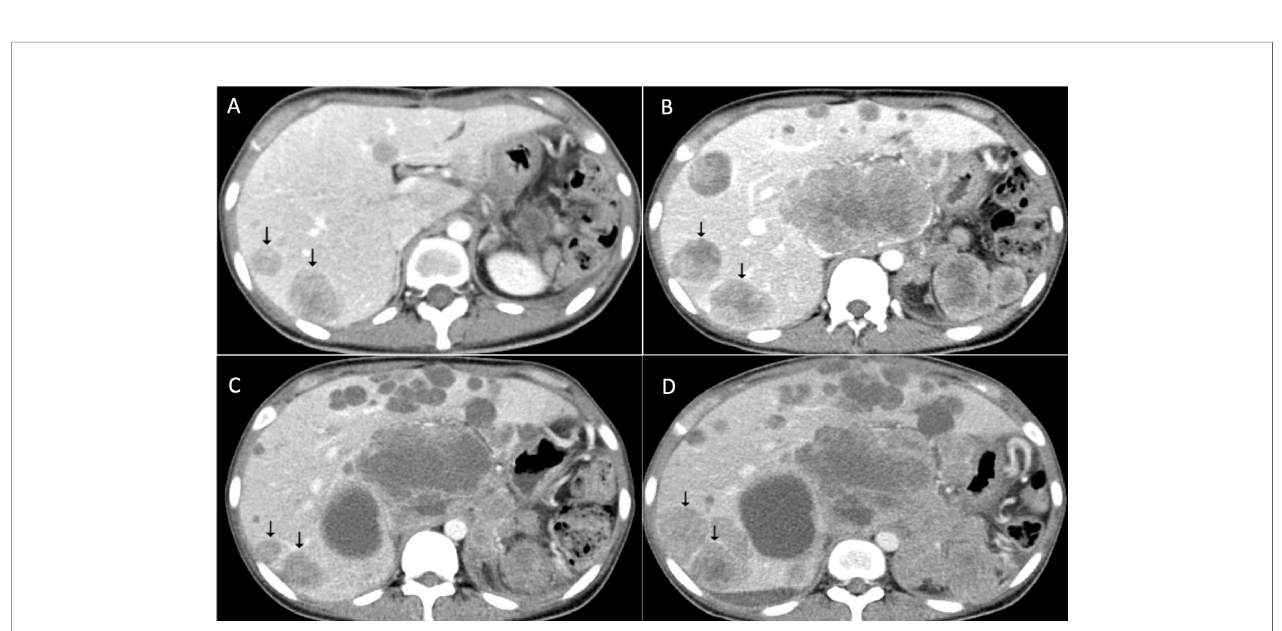
FIGURE 4 | Response of apatinib for metastatic PEComa of the liver. (A) Multiple hepatic metastases revealed after surgery. (B) Tumor progression after everolimus treatment. (C) Response of hepatic metastases after apatinib treatment. (D) Tumor progression in April